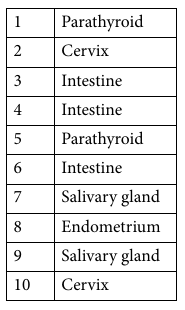
Table 5. Out-of-training-scope (OTS) images.